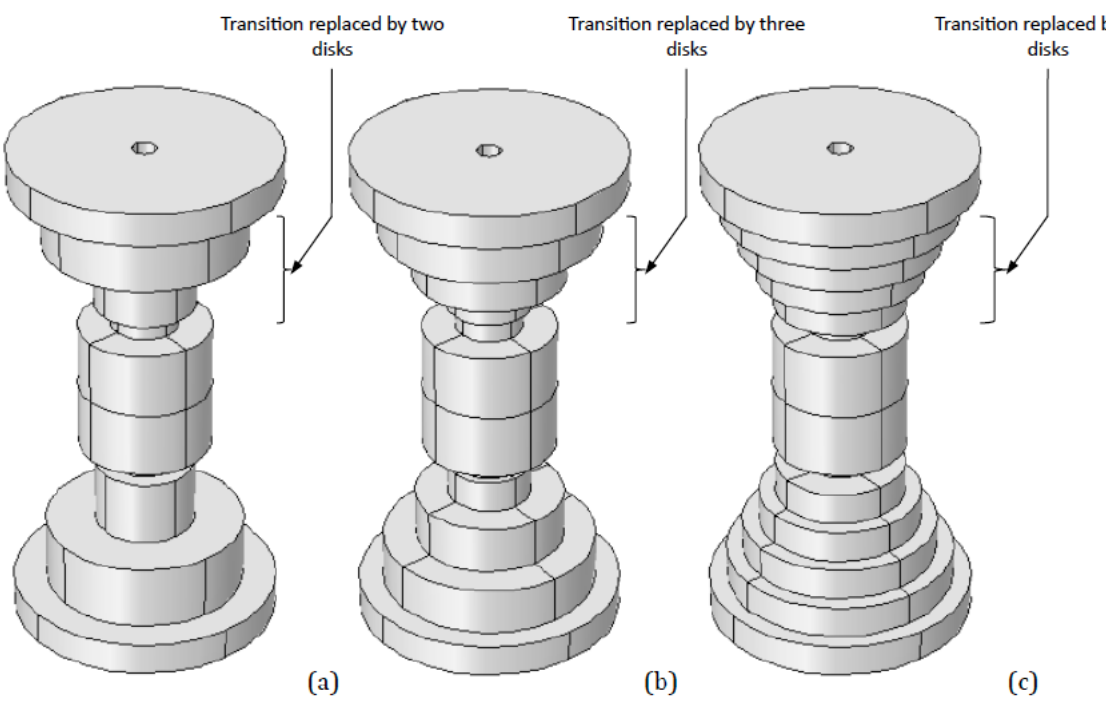
Figure 2. Geometries of ( a ) two transitional disks; ( b ) three transitional disks, and ( c ) four transitional disks